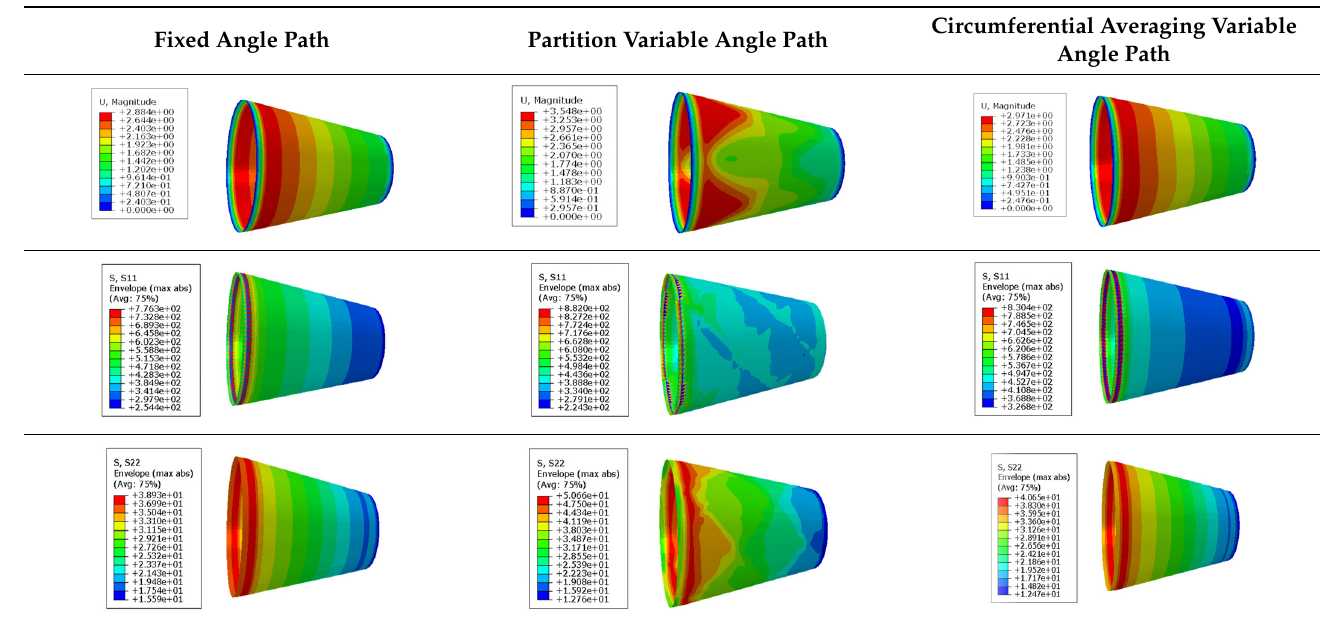
Table 2. Nephogram of displacement and stress distribution.